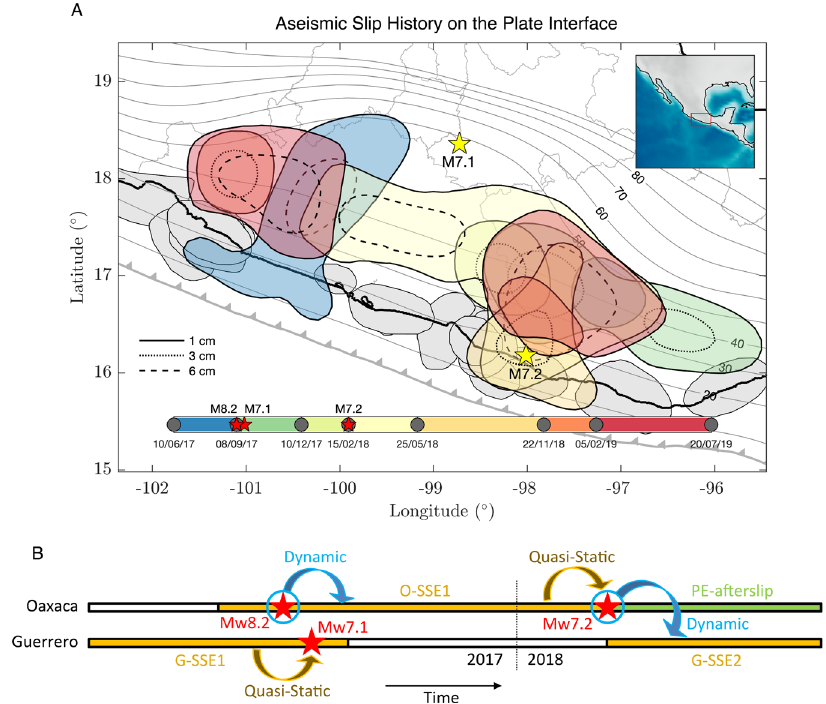
Fig. 3 Evolution of the aseismic slip at the plate interface and types of interaction between the different events. A Aseismic slip patches are those of Figs. 1 and 2 but color-coded according to the timespan of each event (see colorbar). Gray contours show iso-depths (in kilometers) of the 3D plate interface and yellow stars the epicenters of the Puebla-Morelos (Mw7.1) and Pinotepa (Mw7.2) earthquakes. B Sketch showing the evolution of events across the earthquake sequence in the states of Guerrero and Oaxaca, and the nature of the interaction between them, either dynamic or